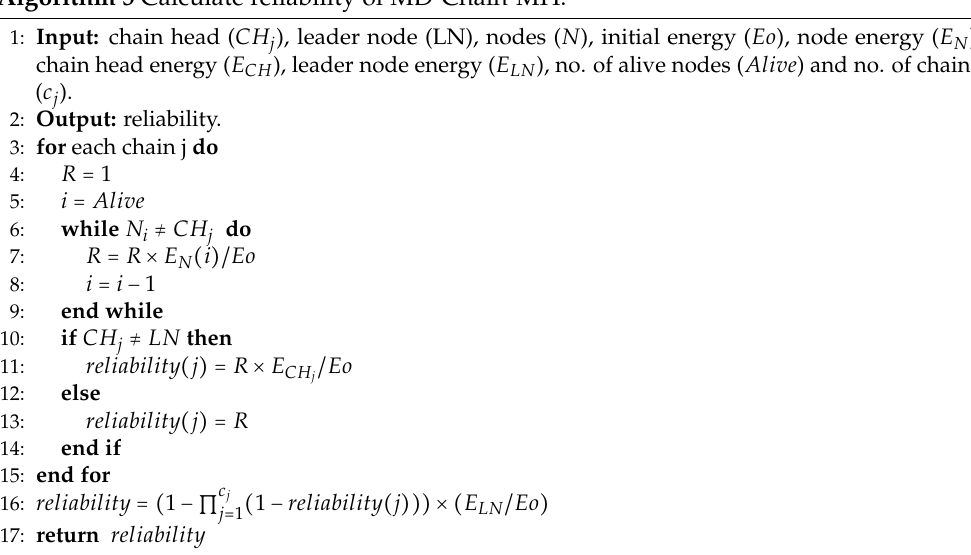
Algorithm 5 Calculate reliability of